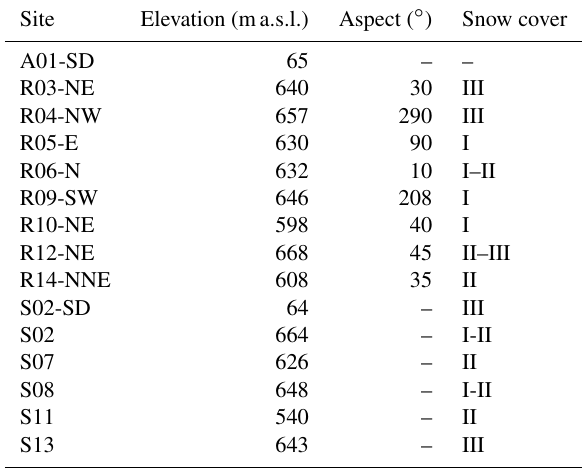
Table 2. Rock wall and soil temperature loggers installed in Polvartinden and Signaldalen. Snow cover = estimated winter snow cover based on a simple evaluation of day to day temperature vari- ability and standard deviation compared to reference logger R05, di- vided into three categories: (I) snow cover mostly absent, (II) snow cover over short periods, (III) snow cover over longer periods.